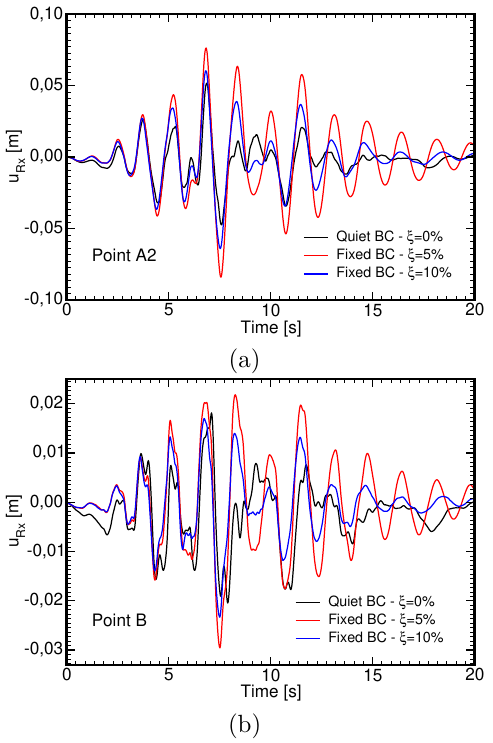
Figure 11. Time variation of relative displacement at selected points during the period of strong motion: a) point A, b) point